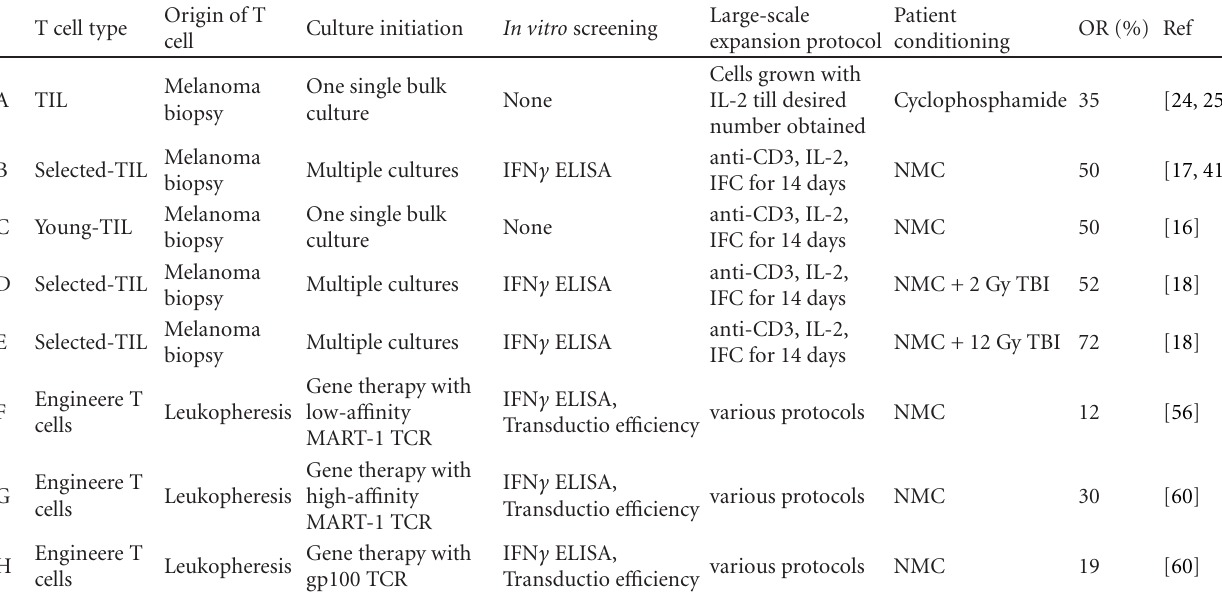
Table 1: Comparison of published adoptive T cell transfer studies for melanoma